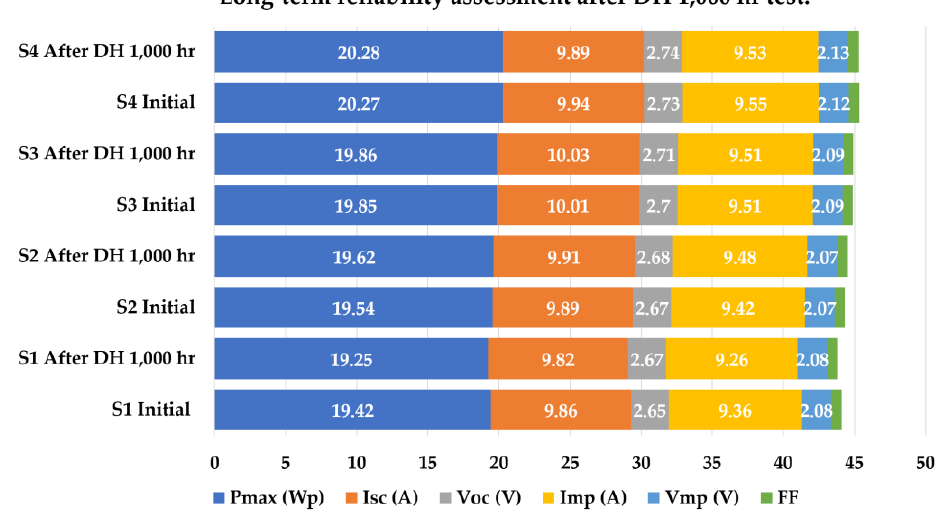
Table 8. Electrical characteristics of unit module samples.